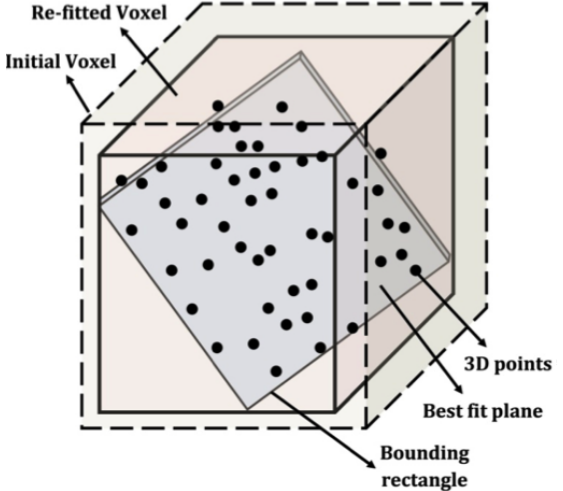
Figure 5. Estimation of V ol corr and Area corr for the 3D points of the corroded part contained in each adapted